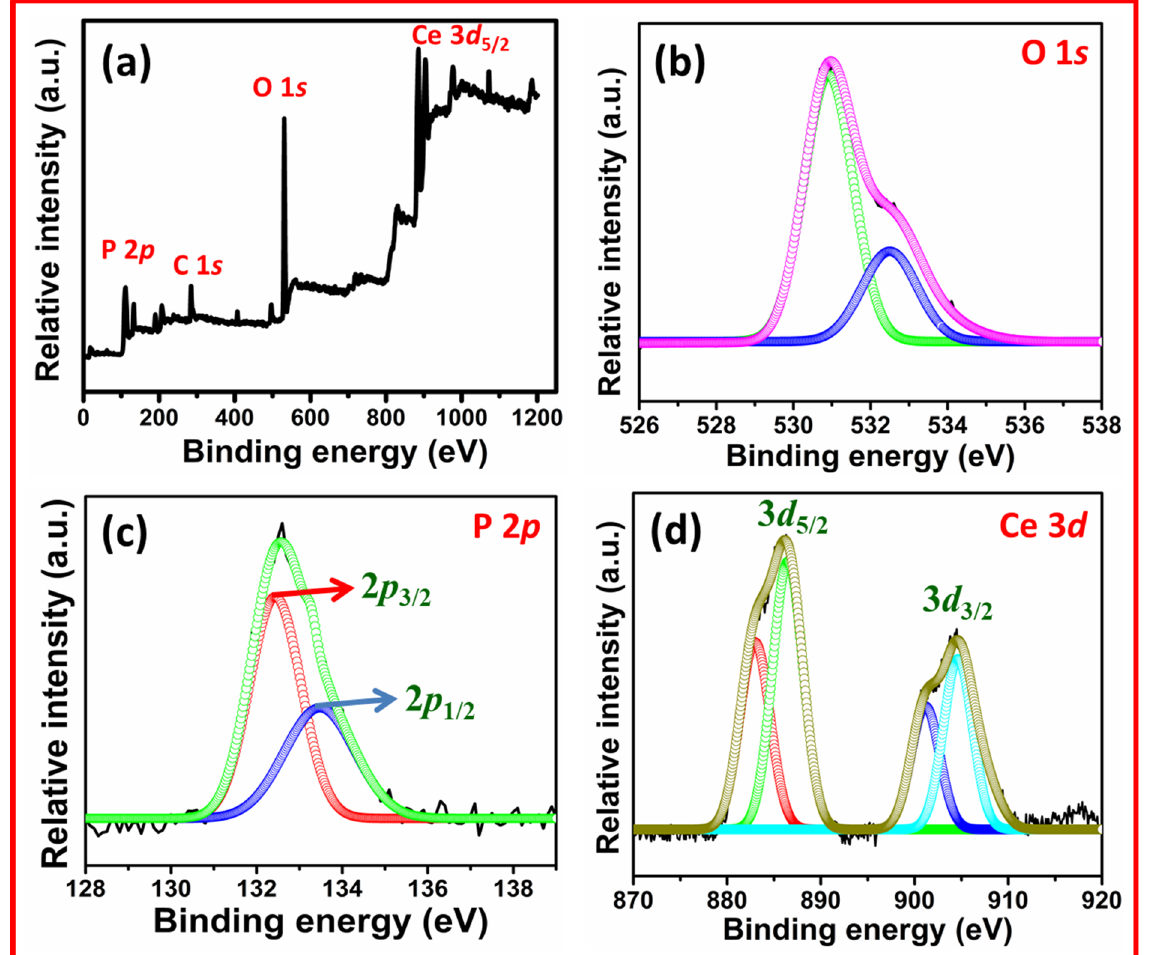
Figure 3. ( a ) XPS survey spectrum of Ce(HPO 4 ); ( b – d ) deconvoluted spectrum of O 1 s , P 2 p , and Ce 3 d , respectively.